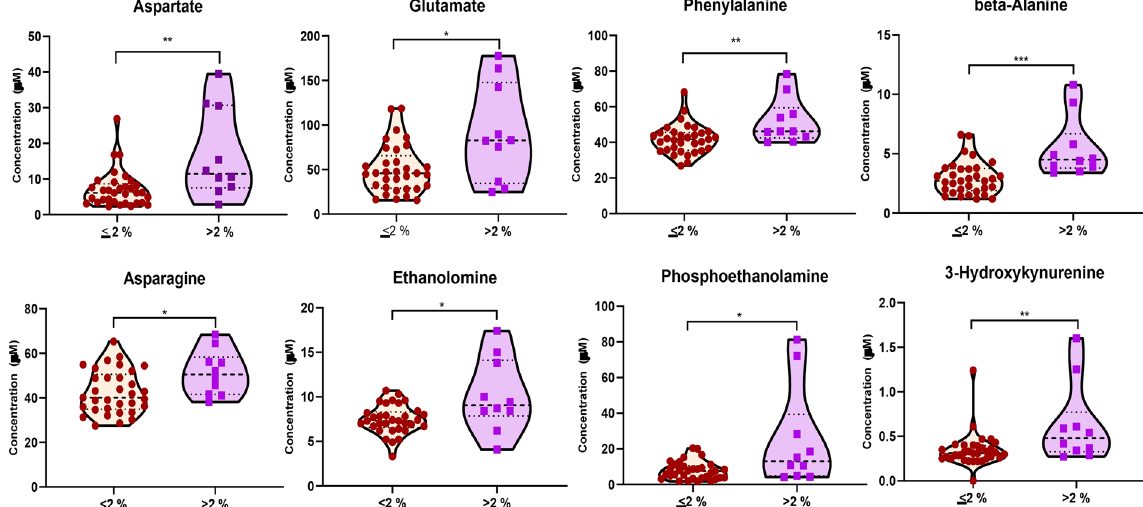
Figure 8. Violin plots comparing the median concentrations of various amino acids and metabolites in the bone marrow plasma from MGUS and MM patients based on whether the S-phase of their cPCs were low ( < 2%) (N = 33) or high ( > 2%) (N = 10). Data was analyzed by Mann-Whitney U test where *** p < 0.001, ** p < 0.01, * p < 0.05, # p < 0.1 but > 0.05, n.s.